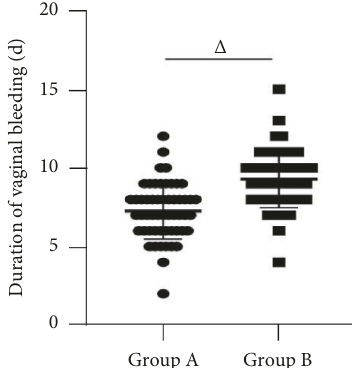
Figure 5: Uterine blood flow index.